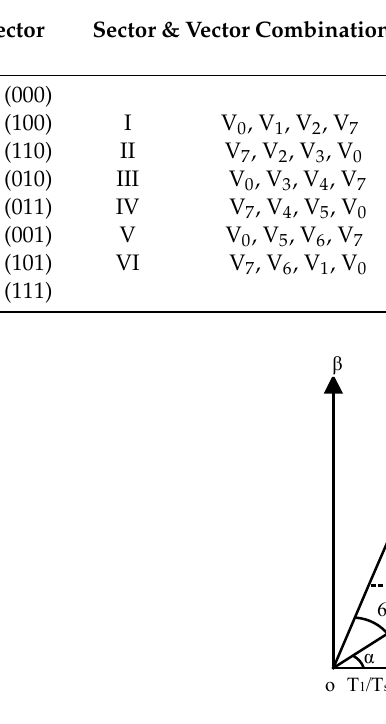
Figure 5. Vector representation of the SVM signal in sector 1. Table 2. Space vectors state and the switching sequence.